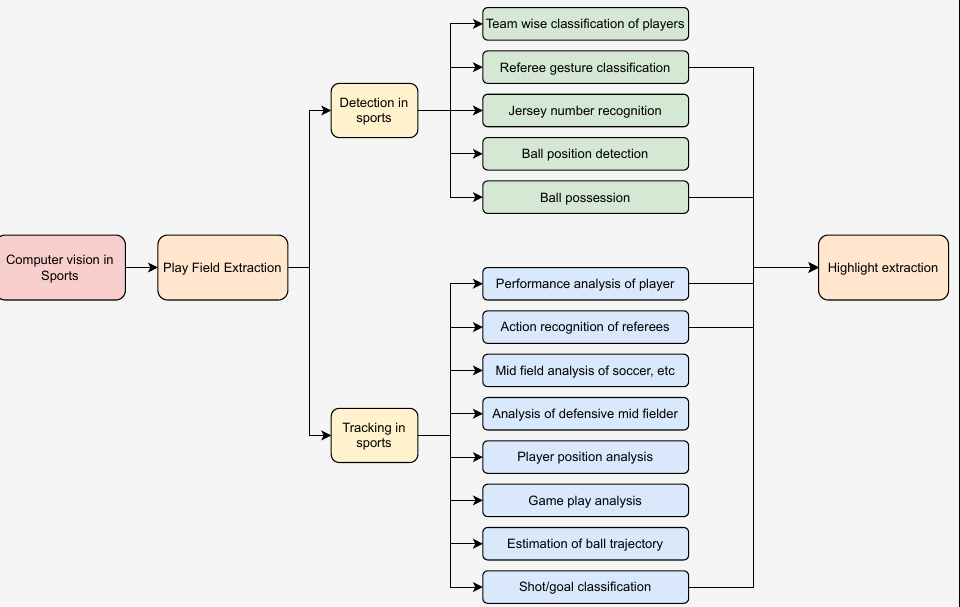
Figure 2. Framework of processing and analysis of different applications in sports